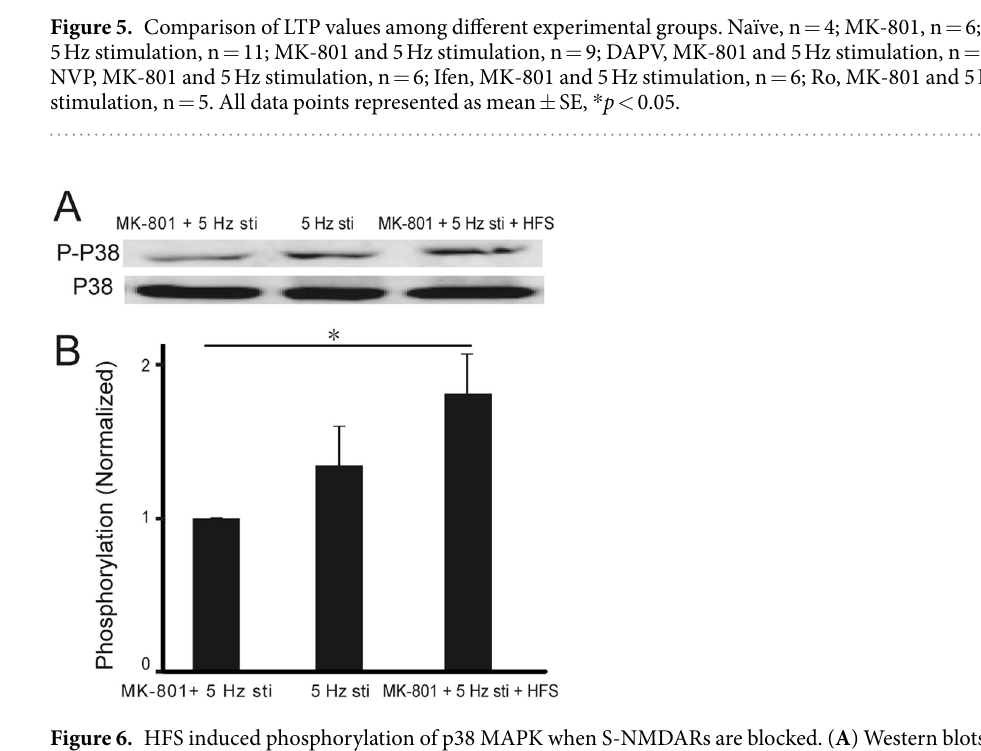
decay time constant of NMDA-EPSCs were used to distinguish the currents from S- and ES-NMDARs. Under our experimental conditions, the rising time and decay time constant of NMDA-EPSCs did not statistically vary with the 5-Hz stimulation, indicating that extrasynaptic NMDA-EPSCs were not activated by the stimuli, as previously reported 19 . For the trafficking of NMDARs, earlier experiments using cultured hippocampal neurons showed that ES-NMDARs are highly mobile at the surface of neurons and able to diffuse into the synaptic compartment within minutes 23, 24 . This raises the question of whether the ES-NMDARs diffuse into synaptic area, leading to incomplete inhibition of S-NMDARs before HFS is applied. It has been reported that the lateral mobility of NMDARs is less than α -3-hydroxy-5-methylisoxazole-4-propionie-acid receptors (AMPA receptors), and changes in neuronal activity do not modify NMDAR mobility 24, 25 . In addition, Harris and Pettit 6 reported that